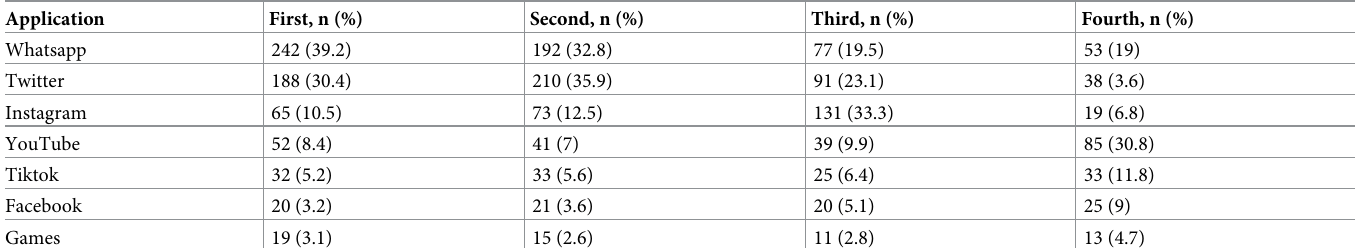
Table 6. Frequently used smartphone applications ( N = 670).